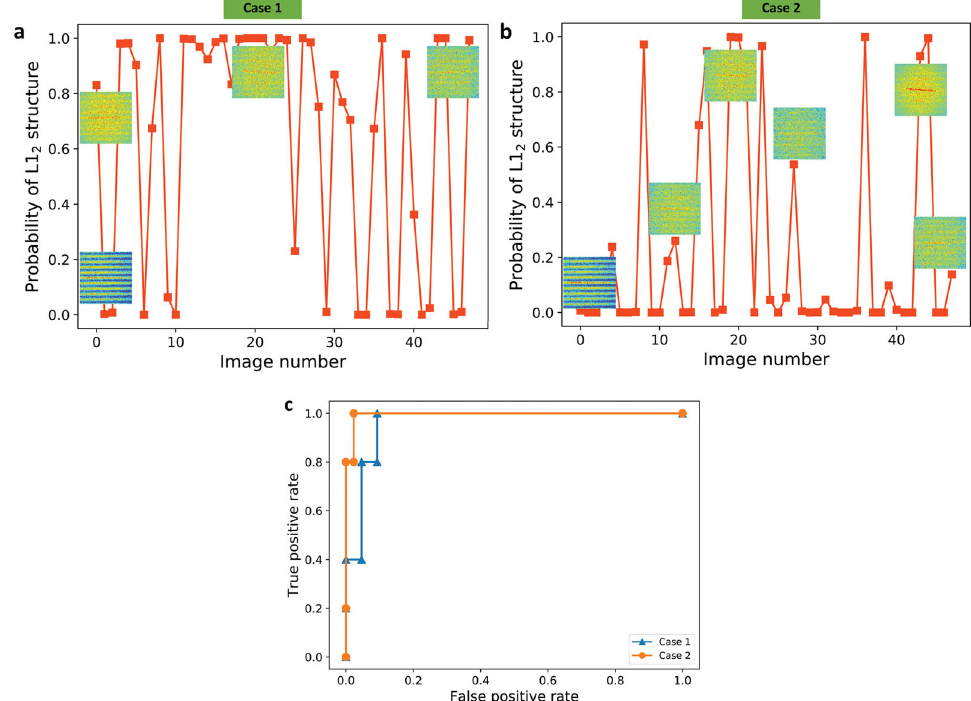
Fig. 4 Test results in experimental data. Predicted L1 2 structure probability of a small volume of APT data (Fig. 1c) in a case 1 and b case 2. The corresponding part zx -SDMs are attached. c ROC curves of the two